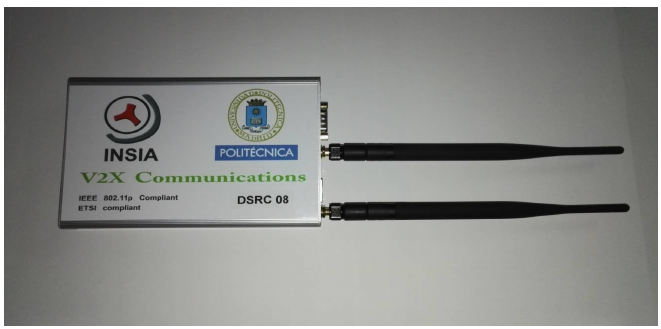
Figure 1. DSRC INSIA ‐ V2X (Dedicated Short ‐ Range Communications) module.